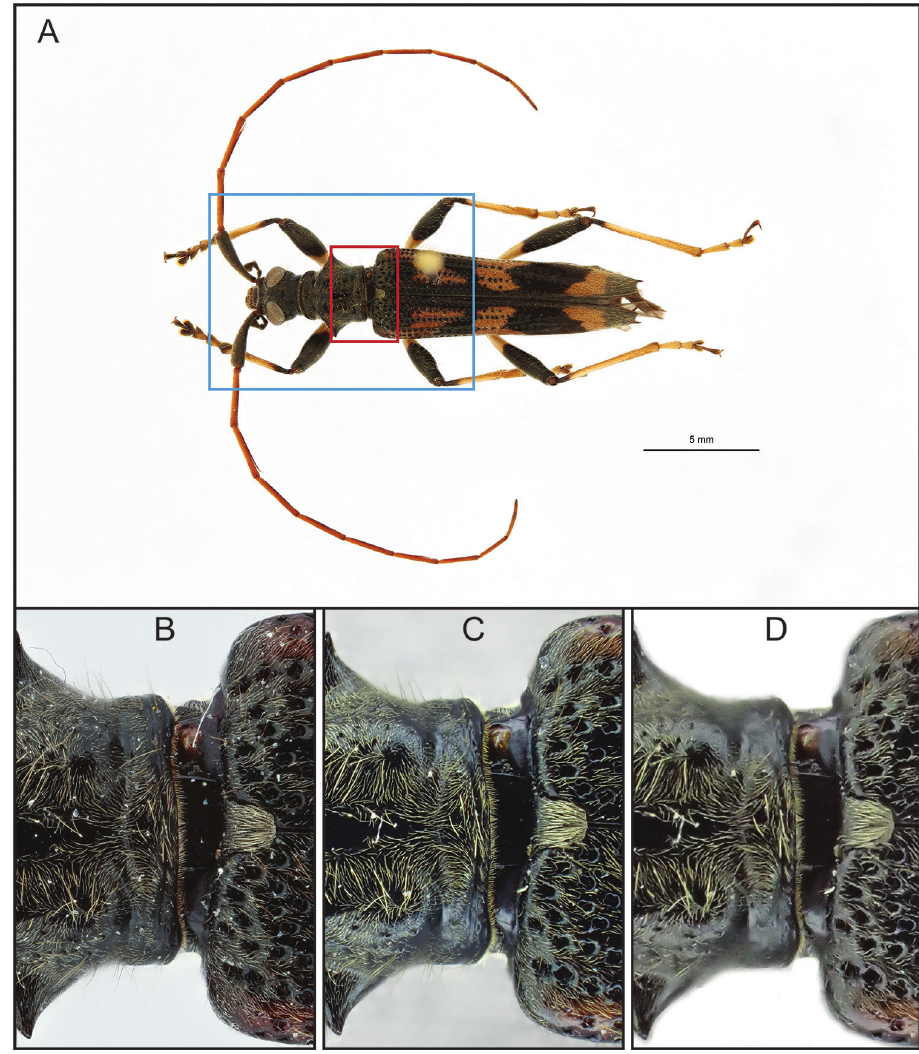
Figure 1. Comparison of the Elytrimitatrix digitized with the professional setup ( A shot with the 60 mm macro lens and B with the Canon MP-E 65 mm lens), the compact camera’s manual focus stacking mode ( C ) and internal stacking mode ( D ). A depicts the whole specimen as would be shot for publication purposes. The red box indicates the section shown in B, C, D and the blue box indicates how the specimen was framed in these three images. Note that the stronger reflections in C, D are the result of a different lighting